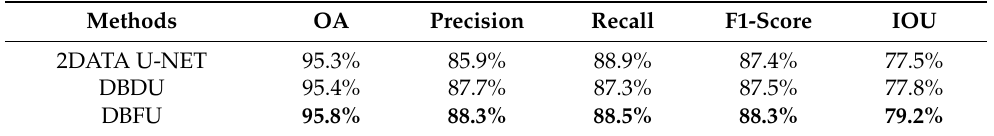
Table 5. Comparison of accuracy of 2DATA U-NET, DBDU and